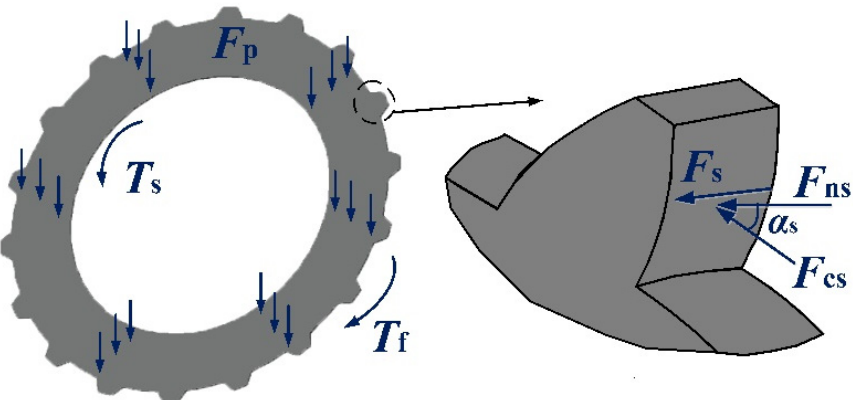
Figure 3. Force diagram of the separate plate.